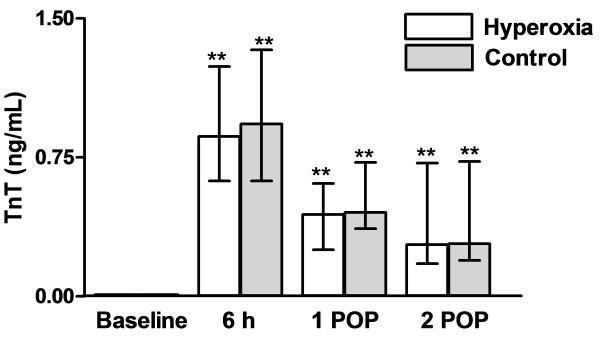
Concentrations of cTn T at baseline, 6 h after declamping the aorta and in the 1stand 2ndpostoperative mornings (POP). Data are given as median with interquartile range. ** p < 0.01 in comparison with baseline.